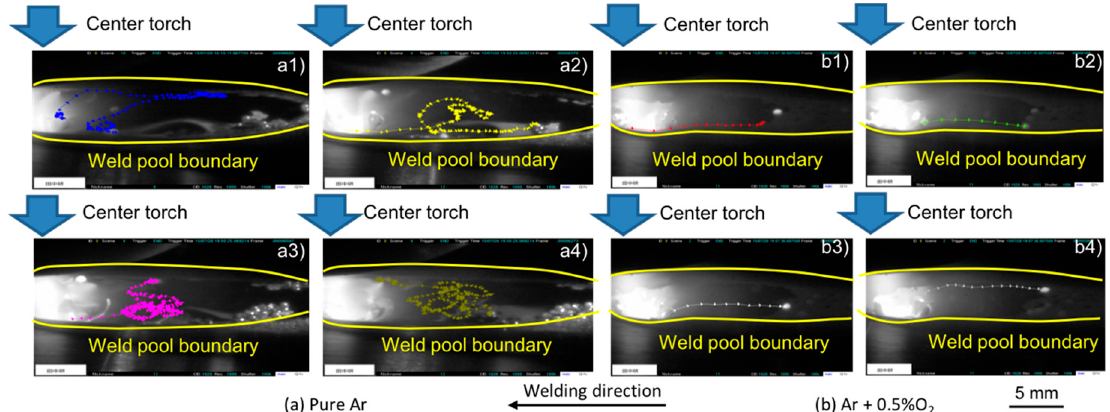
Figure 10. Four typical series of images of observed convection on the weld pool surface for both pure Ar and Ar + 0.5% O 2 . ( a ) pure Ar, ( b ) Ar + 0.5% O 2 .